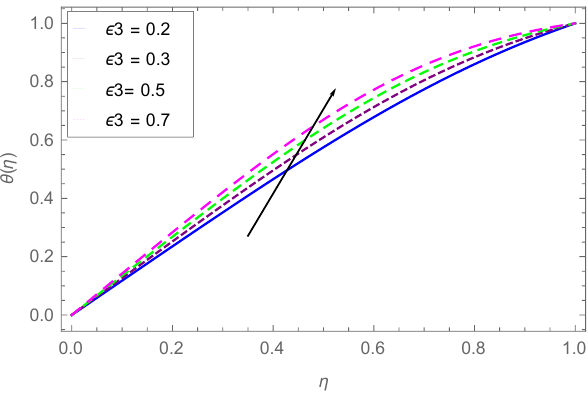
Figure 11. Figure showing θ ( η ) dependence on (cid:101) 3